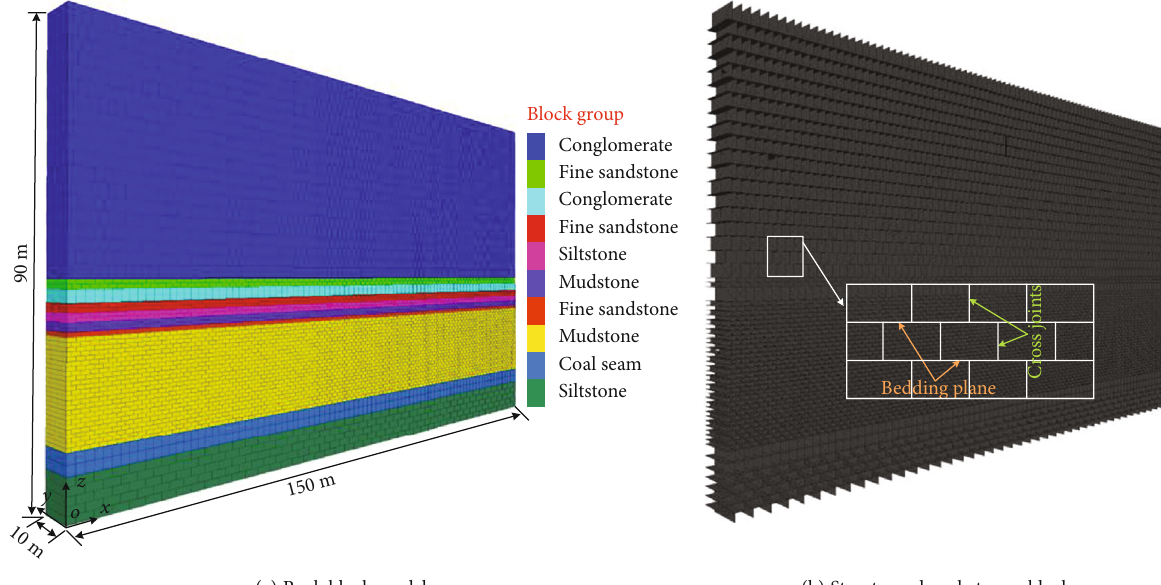
Figure 8: Schematic diagram of the extra-thick roof in the 3DEC